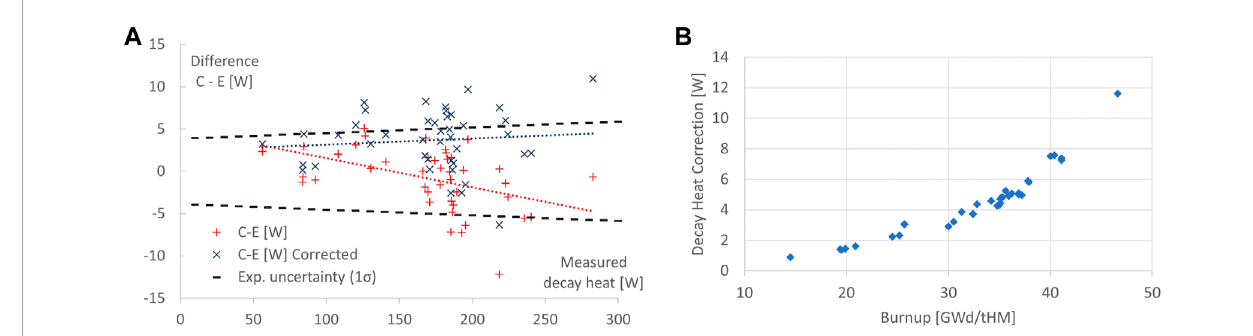
FIGURE 6 Effect of correction factor application to CLAB BWR data. (A) C/E-1 values: original results and with correction applied. (B) Burnup dependence of correction